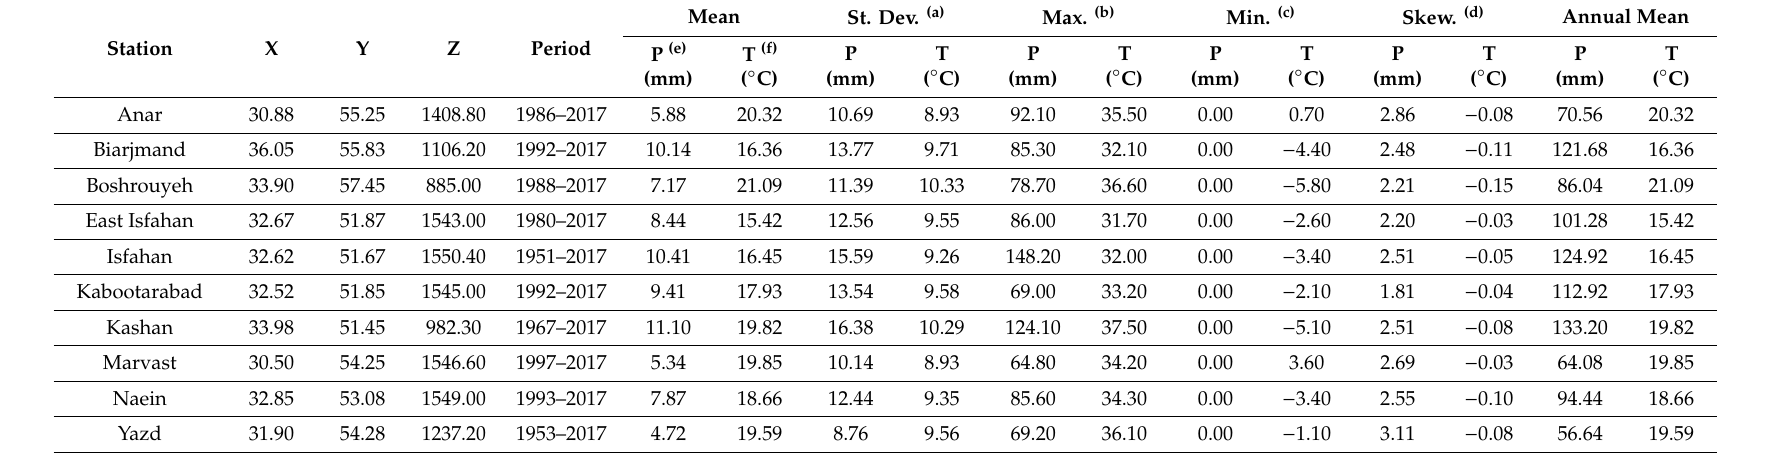
Table 1. Synoptic stations’ position and data